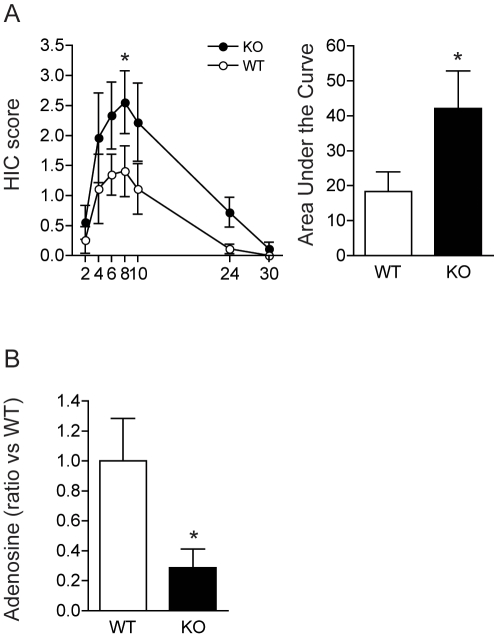
The Absence of ENT1 Increases the Development of Alcohol Withdrawal Seizure in Mice.(A) Handling induced convulsion scores during the 30 h-period following removal from ethanol vapor chambers. ENT1 null mice had higher scores than wild type mice at 8 h after the ethanol withdrawal (*P<0.05, Tukey test). Area under the curve analysis also shows the increased withdrawal seizure in ENT1-null mice compared to wild-type littermates (*P<0.05, two-tailed t-test). For each genotype, n = 9. (B) Reduced adenosine levels in the striatum of ENT1 null mice compared to wild-type littermates (*P<0.05, two-tailed t-test). For each genotype, n = 8. All data are expressed as mean ± SEM.